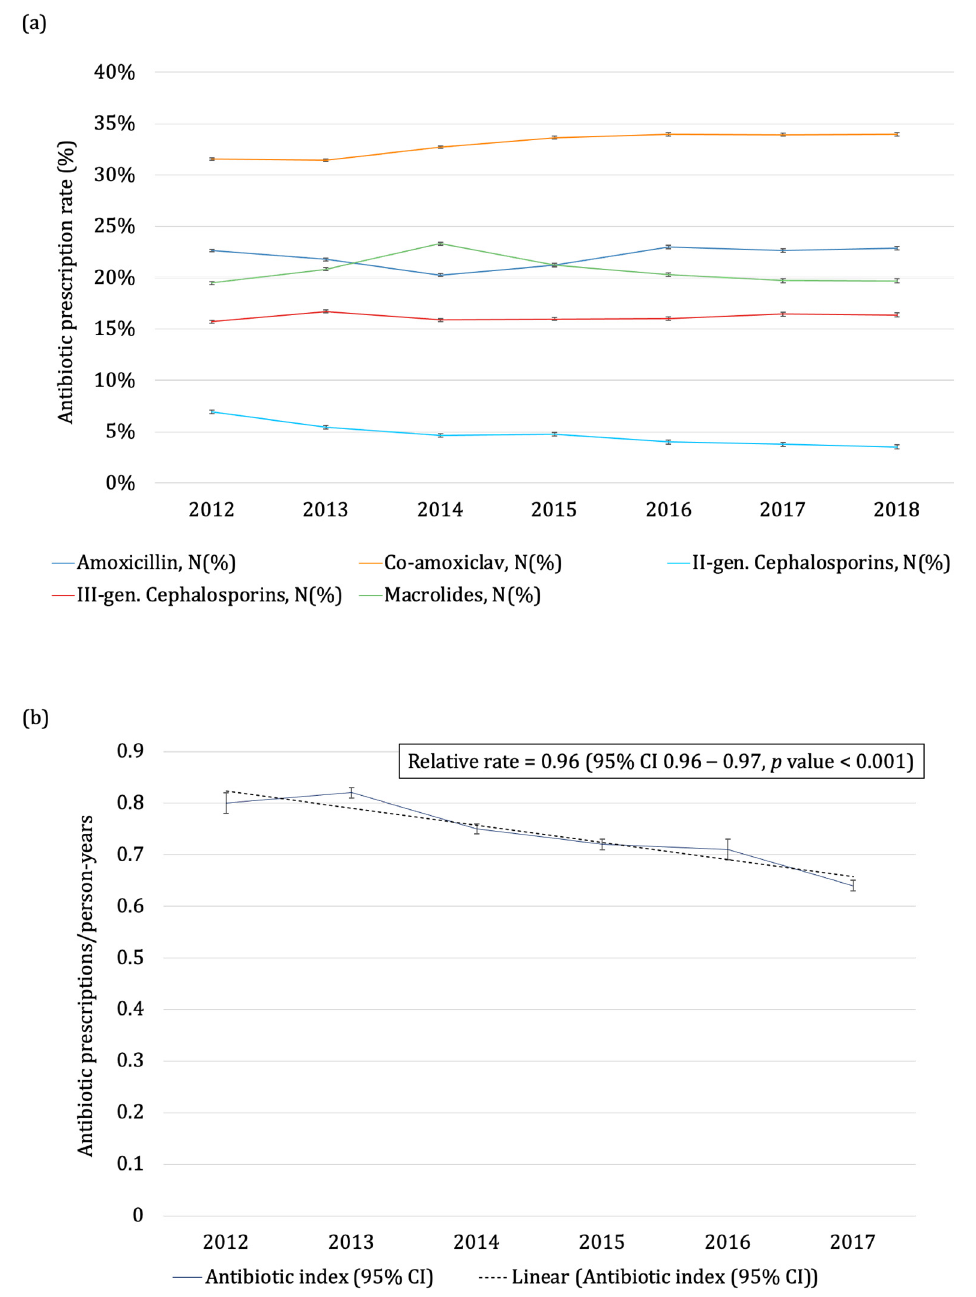
Figure 2. Antibiotic prescription rates of the different antibiotic classes (Panel ( a )) and antibiotic indices (Panel ( b )) by calendar year (Pedianet 2012–2018). Footnotes: The whiskers represent the relative 95% confidence intervals, and the dotted black line in Panel ( b ) represents the linear trend of the antibiotic index. Only antibiotic classes with a prescription rate value greater than 5% are